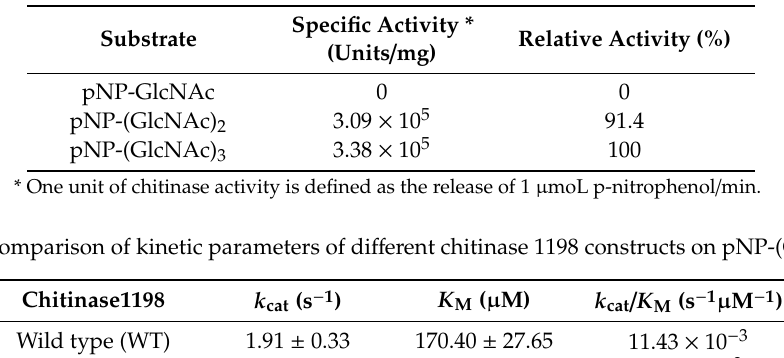
Table 2. Hydrolytic activity of chitinase 1198 on pNP-(GlcNAc) 1–3 .